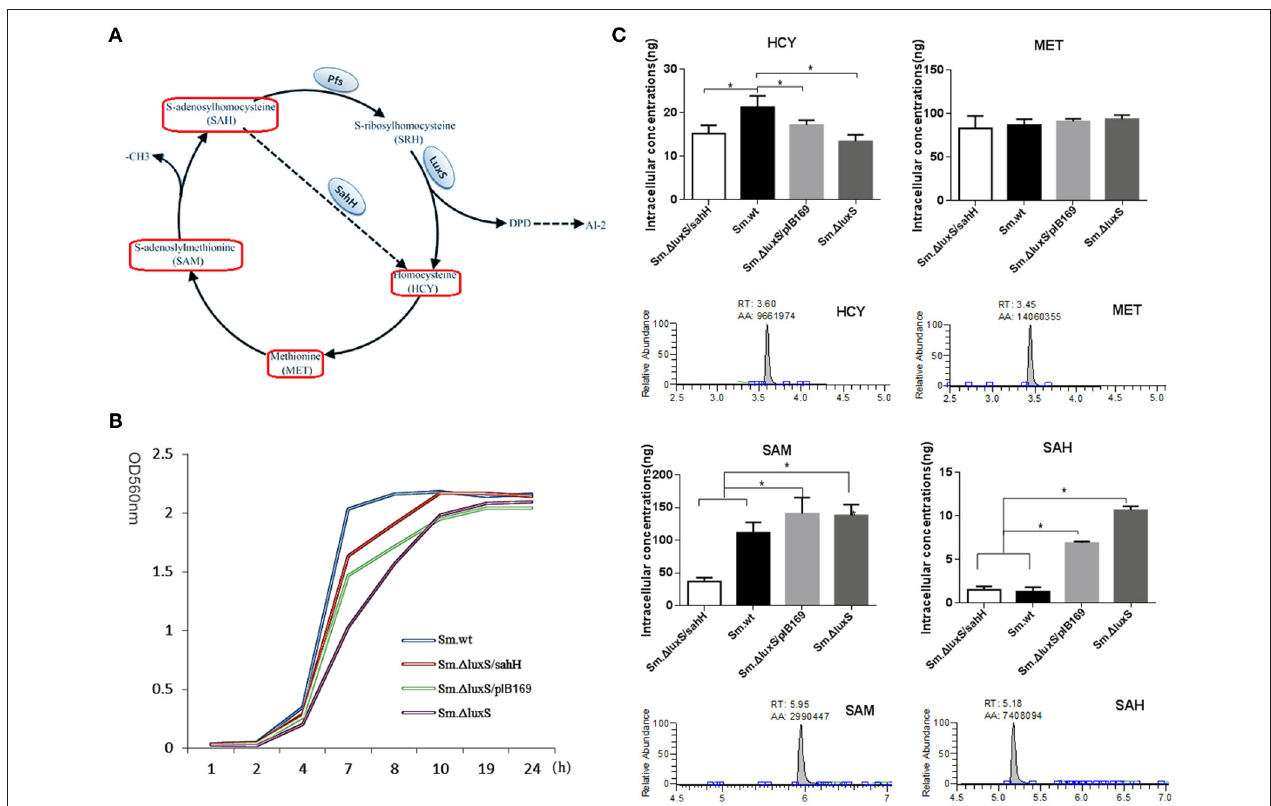
FIGURE 1 | Intracellular concentration of four activated methyl cycle (AMC)-related metabolites in wild-type Sm. wt and derivative strains. (A) The AMC. The detected compounds are circled on the diagram (red box). (B) Bacterial growth curve of the four strains. (C) Intracellular concentrations of the four metabolites and their representative chromatograms. Cell extracts were analyzed with HPLC-MS/MS to determine the intracellular concentrations of methionine, homocysteine, S-adenosyl methionine, and S-adenosyl homocysteine when bacterial strains are cultured overnight and compared to their chromatographic standards. The data shown correspond to the mean calculated intracellular concentrations ± standard deviations of three independent cultures. *Significant differences at P <